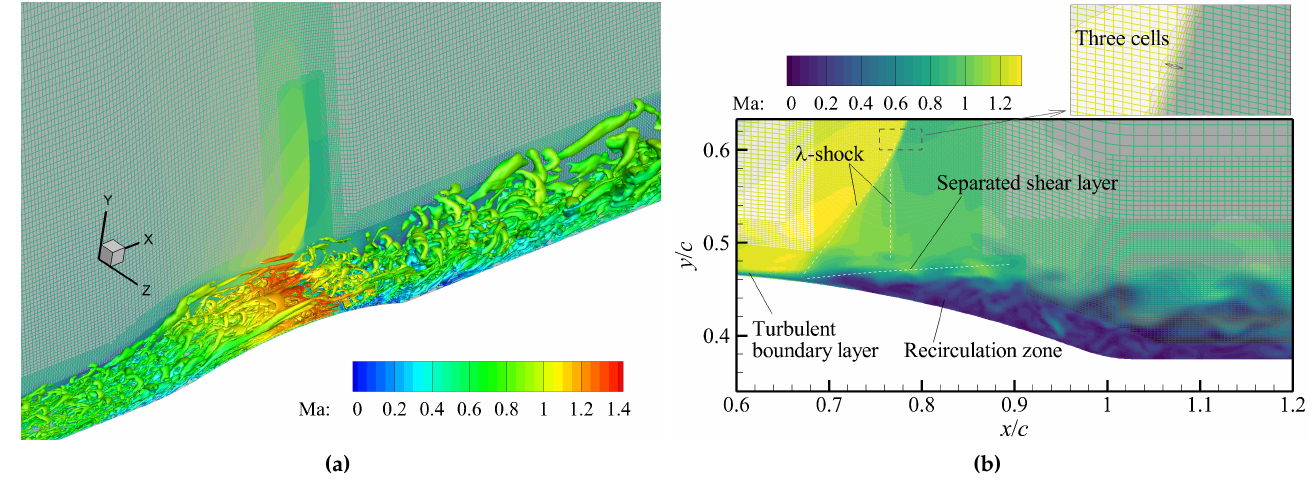
Figure 15. Instantaneous vortex structures visualized by iso-surface of Q -crierion colored by Mach number obtained by SA-DES: ( a ) three-dimensional and ( b ) two-dimensional vertical plane. Table 6. Grid scales near the antisymmetric bump at δ / c = 0.04 for two grid systems. N cell